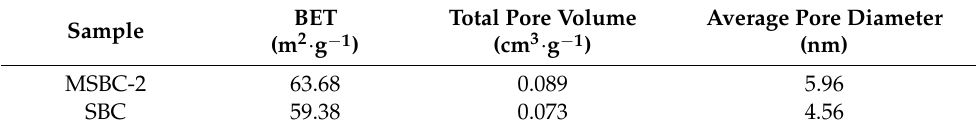
Figure 1. SEM surface morphology of SBC ( a ), × 5000 and MSBC-2 ( b ), × 5000, magnetization curve of MSBC-2 ( c ) and actual separation performance ( d ). Table 1. Specific surface area and pore structure characteristics of MSBC-2 and SBC [31].